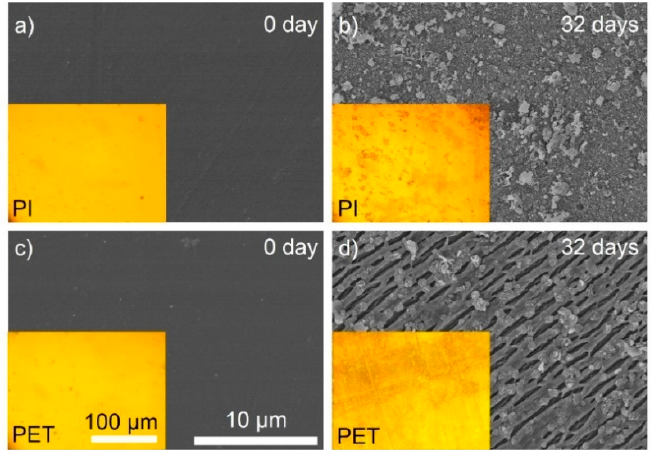
Figure 1. SEM images of ( a , b ) PET and ( c , d ) PI film surfaces: ( a , c ) raw films and ( b , d ) films aged for 32 days. The inserts in SEM images ( a – d ) are the corresponding optical micrographs of PET and PI films.